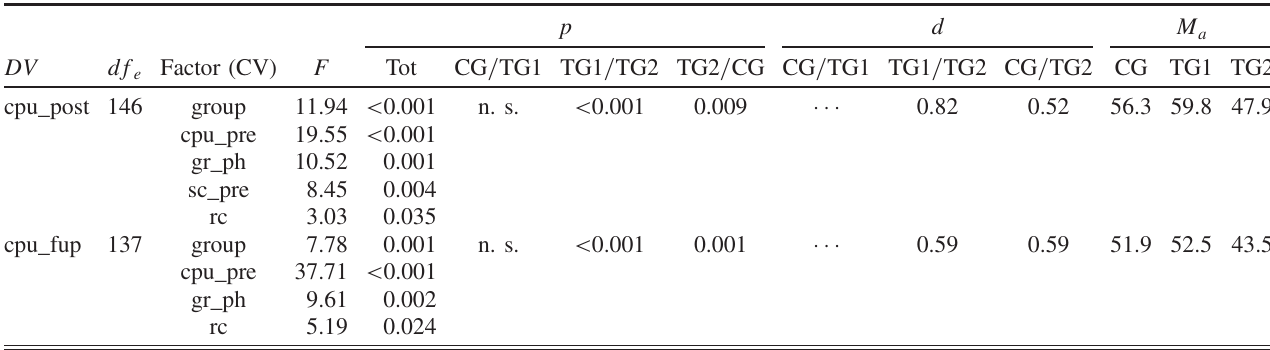
TABLE V. ANCOVA results of the learning test at post-test and follow-up. Dependent variable ( DV ); Error degrees of freedom ( df F statistic ( F ); observed significance level ( p ); effect size Cohen d ð d Þ ; adjusted means ( M and procedural understanding; sc_pre: pre-intervention self-concept, gr_ph: prior grade in physics; rc: reading competence; fup: follow-up).